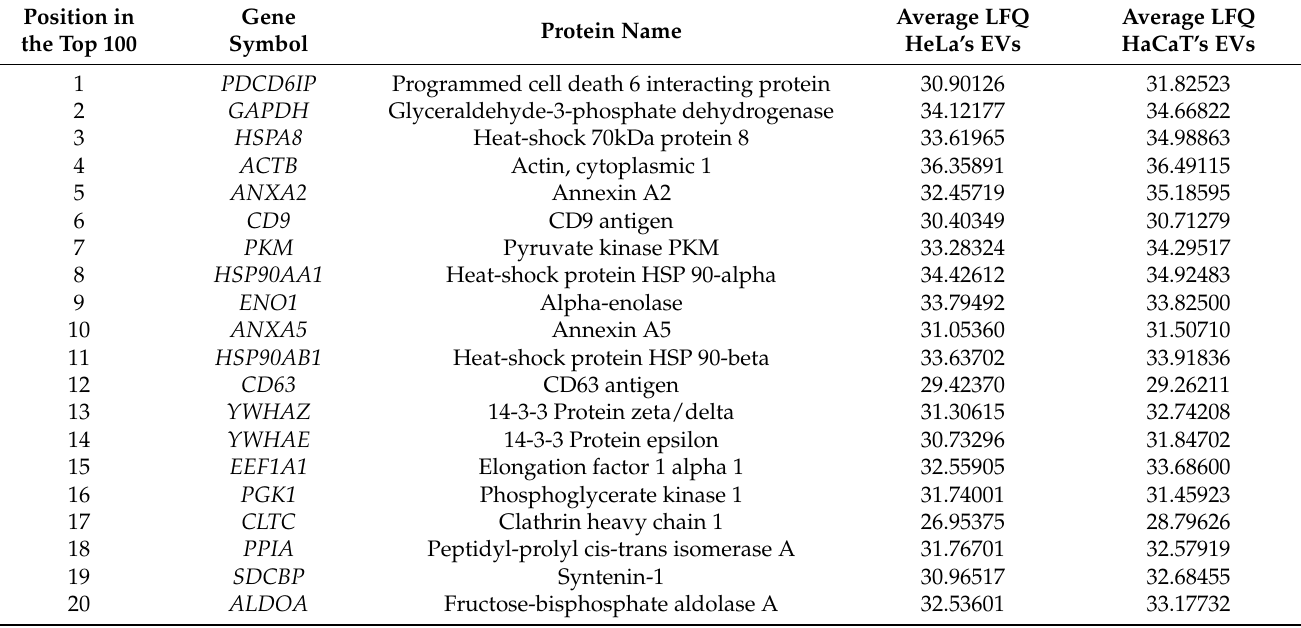
Table 1. Top twenty most reported proteins in EVs according to the Vesiclepedia database and found using LC-MS/MS in HeLa and HaCaT